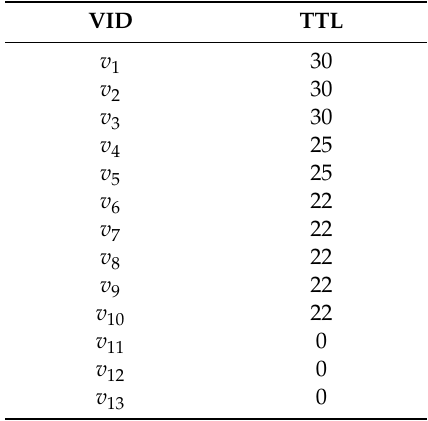
Figure 4. Graph query pattern. Table 1. Time-to-live (TTL) values of vertices.